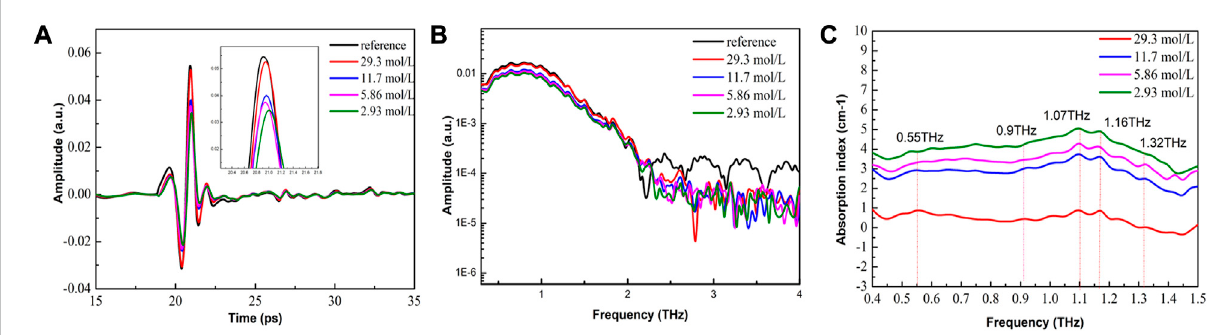
FIGURE 5 THz-ATR spectroscopy of reference (no-load ATR sample cell) and α -lactose solution with different concentrations. (A) Time-domain spectra (see enlarged image for details); (B) The corresponding frequency-domain spectra; and (C) Characteristic absorption